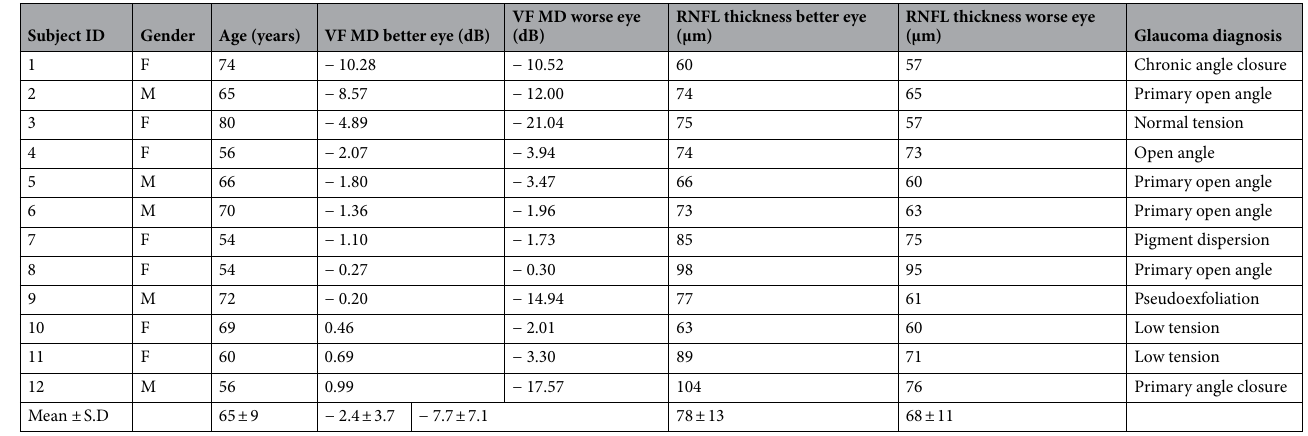
Table 1. Characteristics of participants with